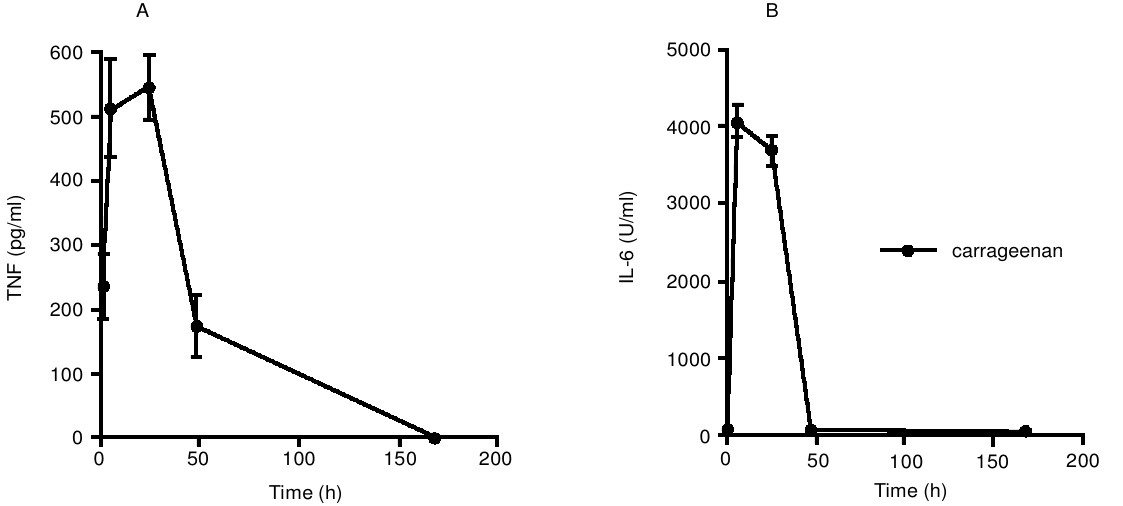
FIG. 2. Time course of TNF (panel A) and IL-6 (panel B) in carrageenan-induced in¯ ammation. Animals were pretreated with 1 ml of sterile saline or 1 ml of 1% carrageenan in sterile saline ( ± d ± ). In saline-treated mice TNF and IL-6 were below the detection limit which was 50 pg ml for TNF and 50 U ml for IL-6. Data are the mean SD of duplicate determinations on at least eight animals.